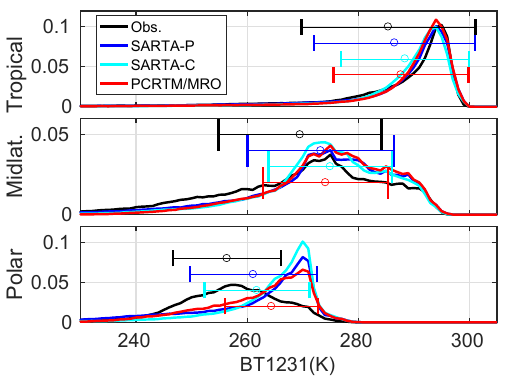
Figure 7. Brightness temperature PDFs for the night non-frozen ocean 1231cm − 1 channel for the data used in Fig. 8 separated trop- ical, midlatitude and polar regions. The whiskers correspond to the brightness temperature means and standard